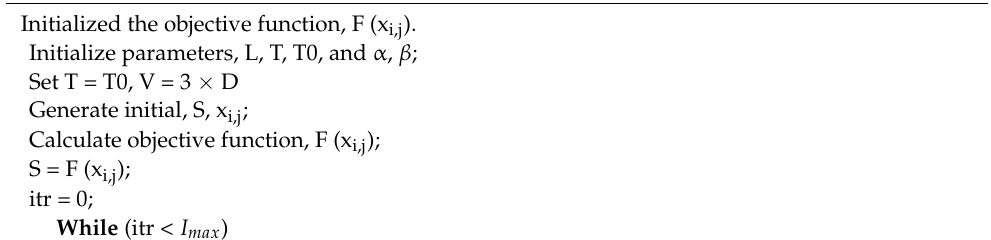
Algorithm 2 Pseudocode of the proposed SA-MCSDN algorithm